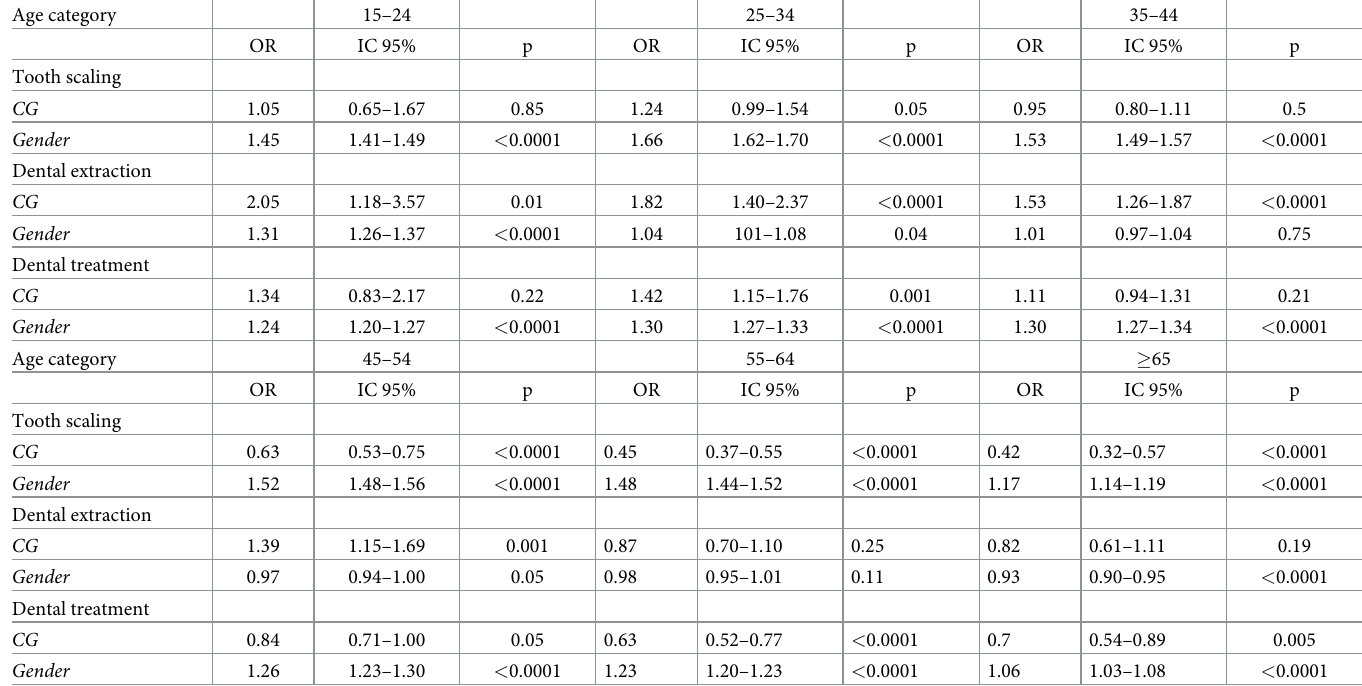
Table 2. Multivariate logistic regressions